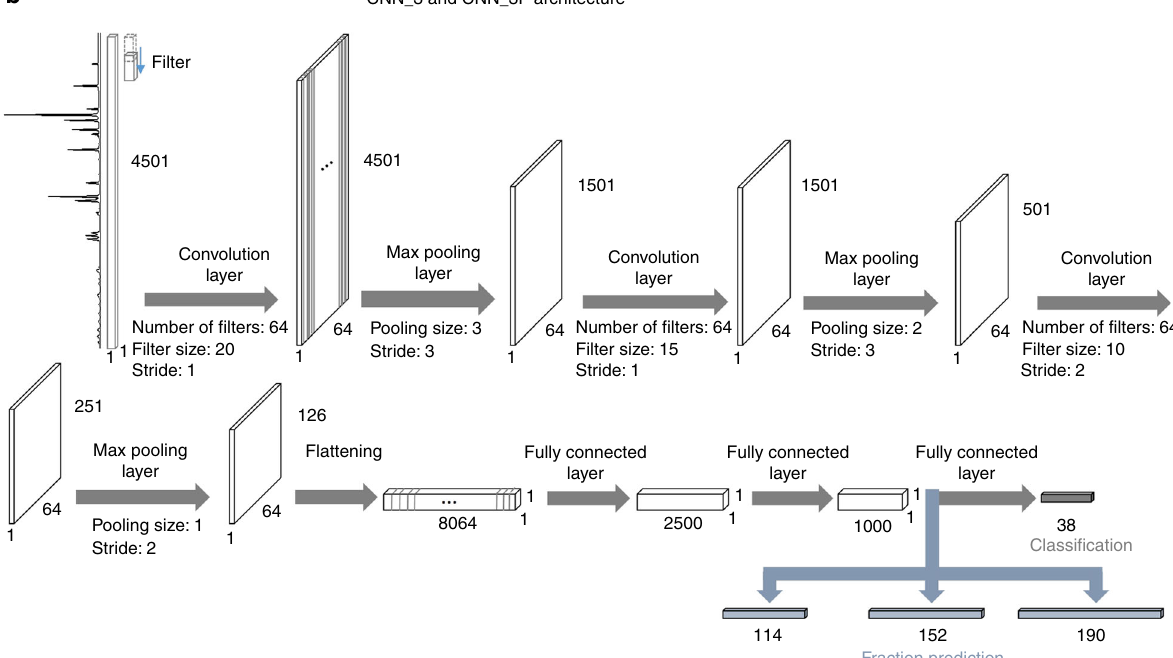
variants, according to this principle, the appearance of the same mixture would never be allowed to repeat. Even mixtures with the same composition (i.e., the same constituent and the same phase fraction) have different peak positions due to the different lattice sizes originating from the different variants and also to the completely different peak shapes originating from the randomly chosen values of Caglioti (u, v, w) and mixing ( η , x) parameters. It is evident that we adopted random u, v, w, x, and η values for each constituent and even different backgrounds and white noise, every